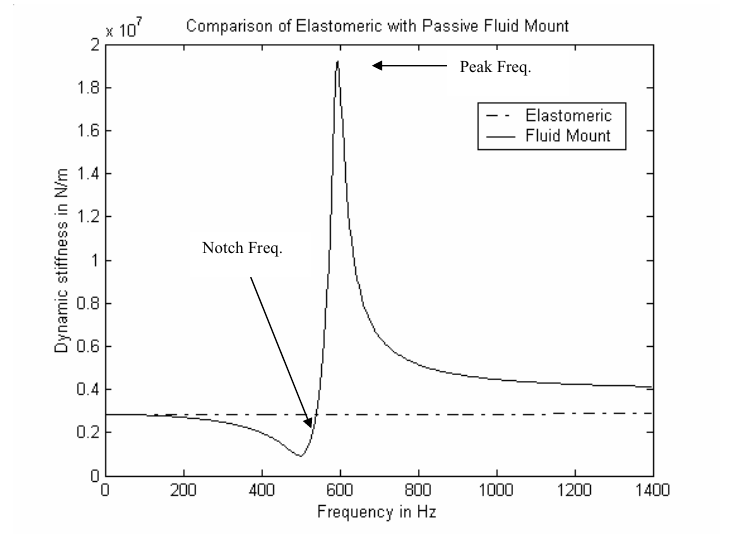
Fig. 10. A Rubber Mount (dashed) versus a Passive Fluid Mount